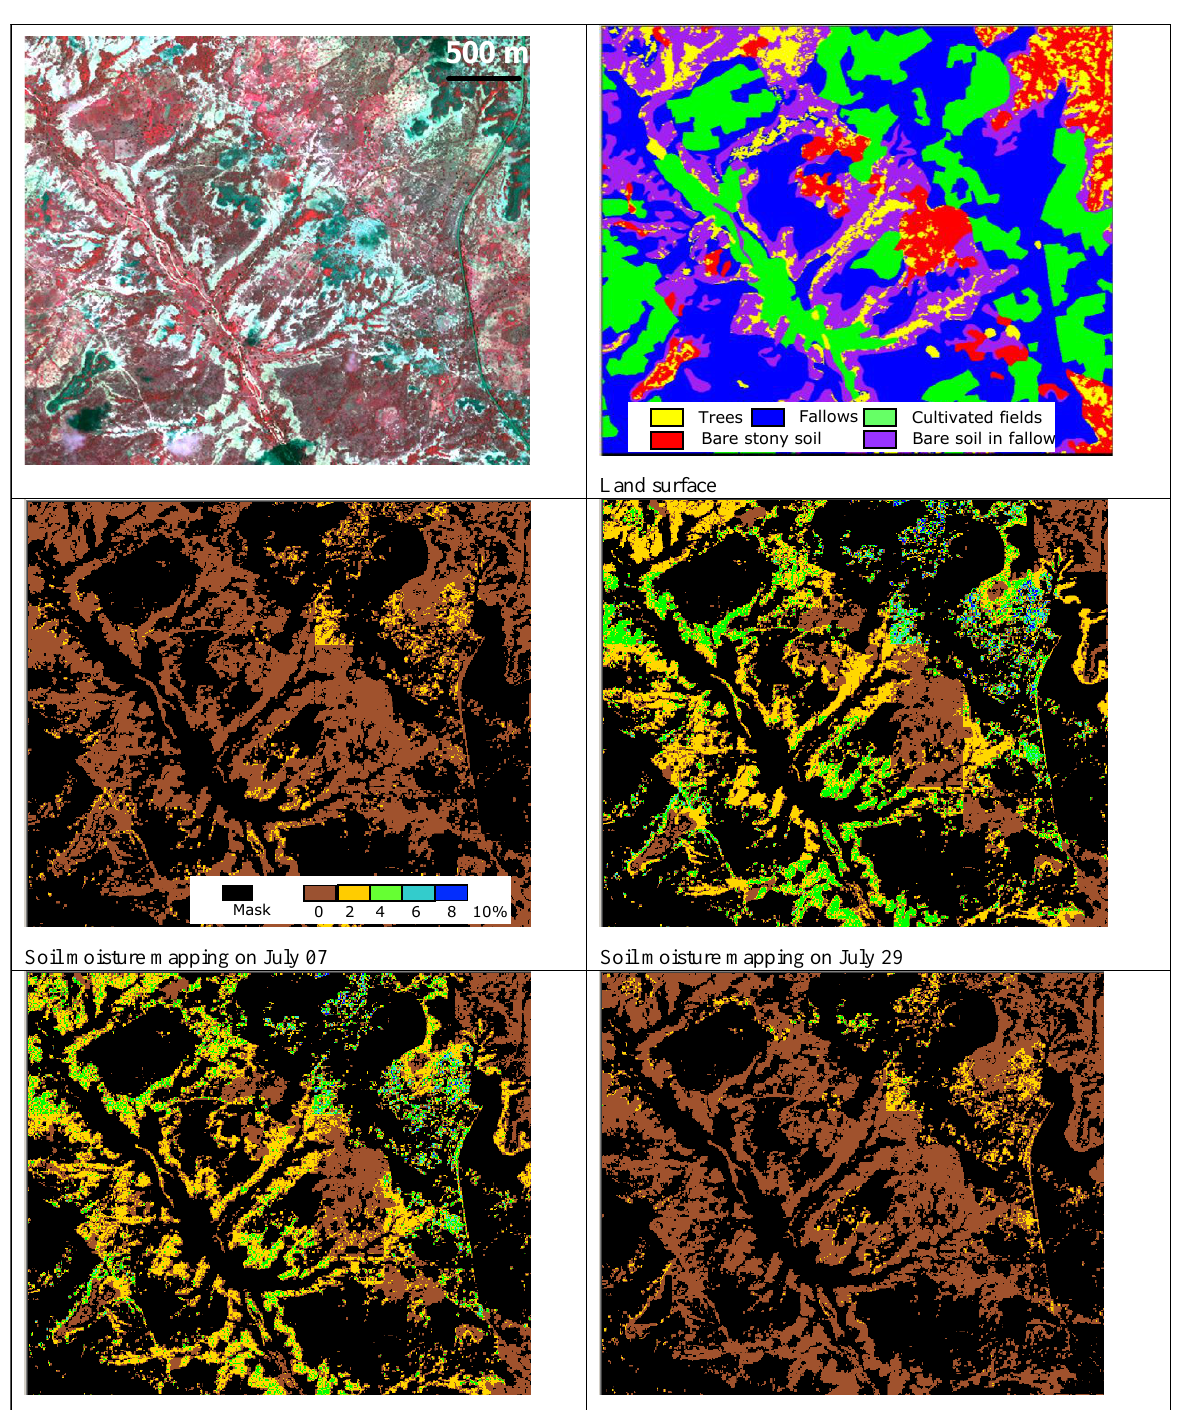
Figure 10. Temporal evolution of soil moisture map on Tamou (method 2, cells of 500 × 500 pixels) (on a segment of TerraSAR